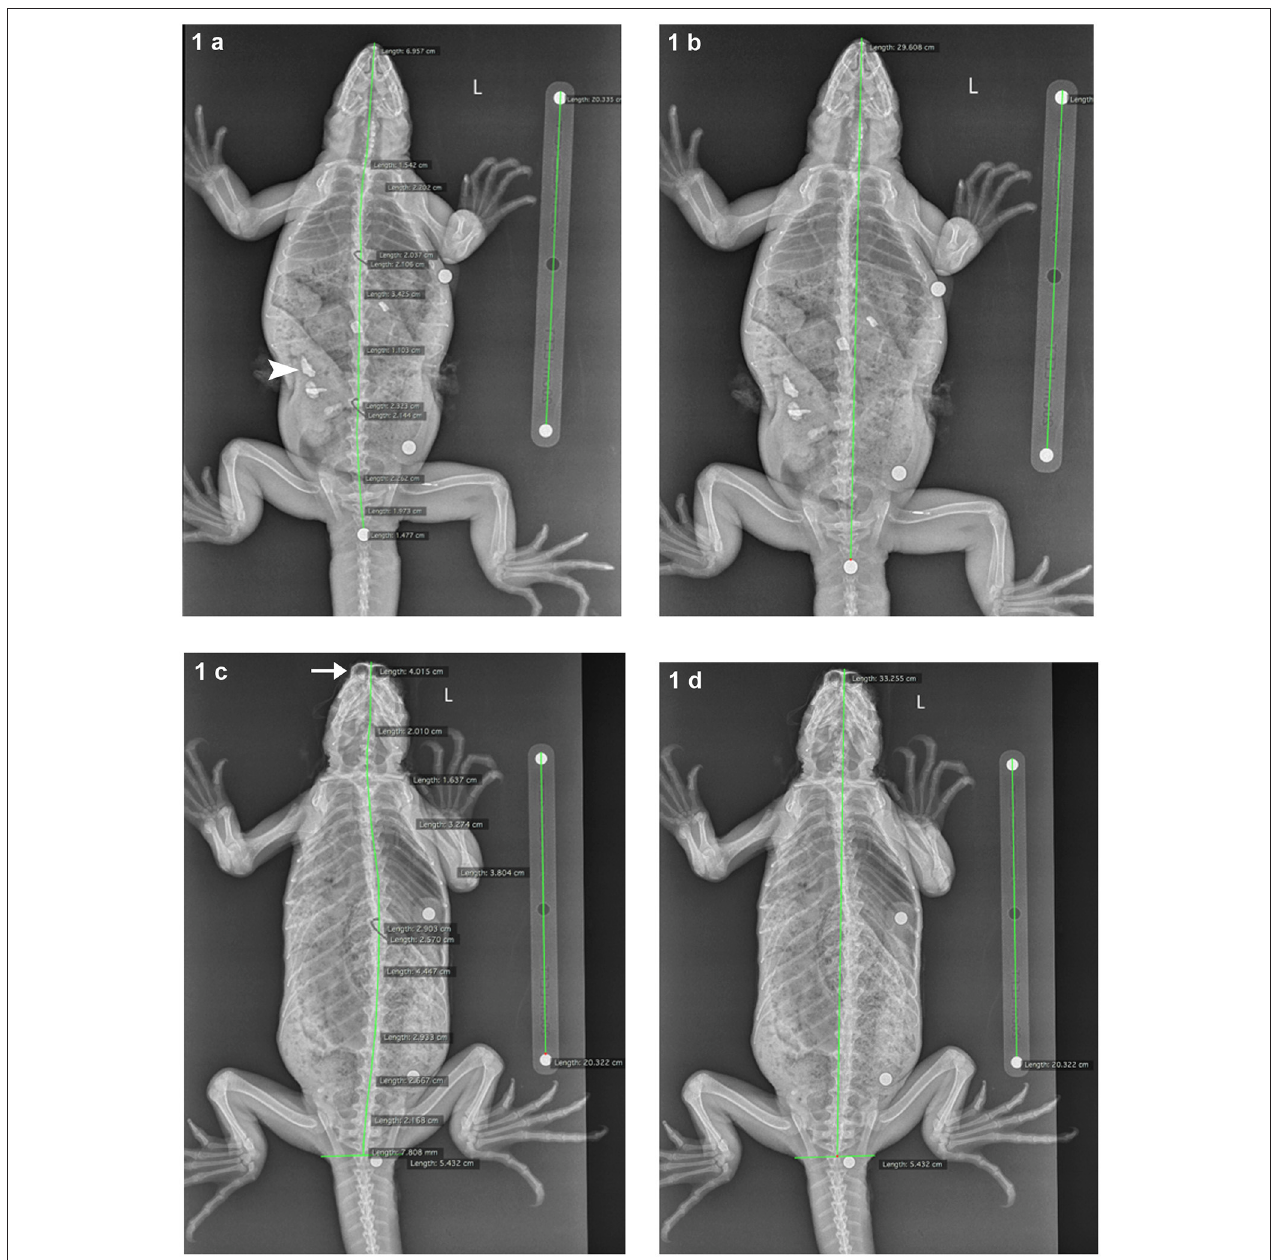
FIGURE 1 | Dorsoventral radiographs of marine iguanas, demonstrating the measurements methods. The 20cm calibration bar is visible adjacent to each iguana (top: 4653144B3E; bottom: no microchip ID). In Method 1 (a) snout-vent length (SVL) was measured using interconnected linear (regions of interest) ROIs bisecting the skull and vertebrae; this technique corrected for small angulations in the spine from the leading edge of the snout to the leading edge of the BB at the vent. In Method 2 (b) SVL was measured using a single linear ROI from snout to vent BB, with no correction for spinal angulation. (c,d) demonstrate the adjustment of these two measurement methods if the vent BB was not located so that it centrally bisected the vertebra at this level. In such cases, a transverse linear ROI was placed at the leading edge of the vent BB, and the caudal-most linear ROI measuring SVL was extended to the central aspect of this transverse ROI (Method 1 adjusted = c , Method 2 adjusted = d ). In (a) angular mineral opaque fragments are visible within the gastrointestinal tract (arrowhead), consistent with ingested substrate. In (c) the frontal sinuses (arrow) are prominently visible, indicating foreshortening of the iguana, secondary to head